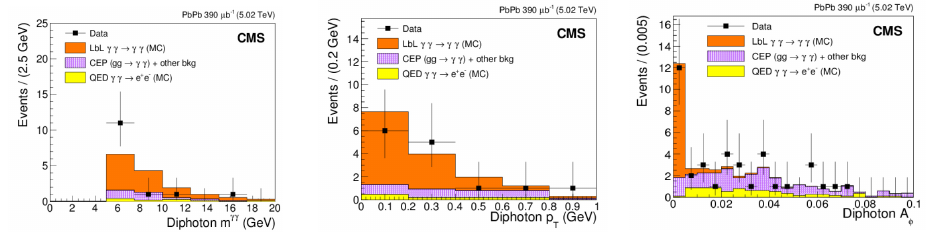
(left), transverse momentum 𝛾𝛾𝛾𝛾 𝑚𝑚